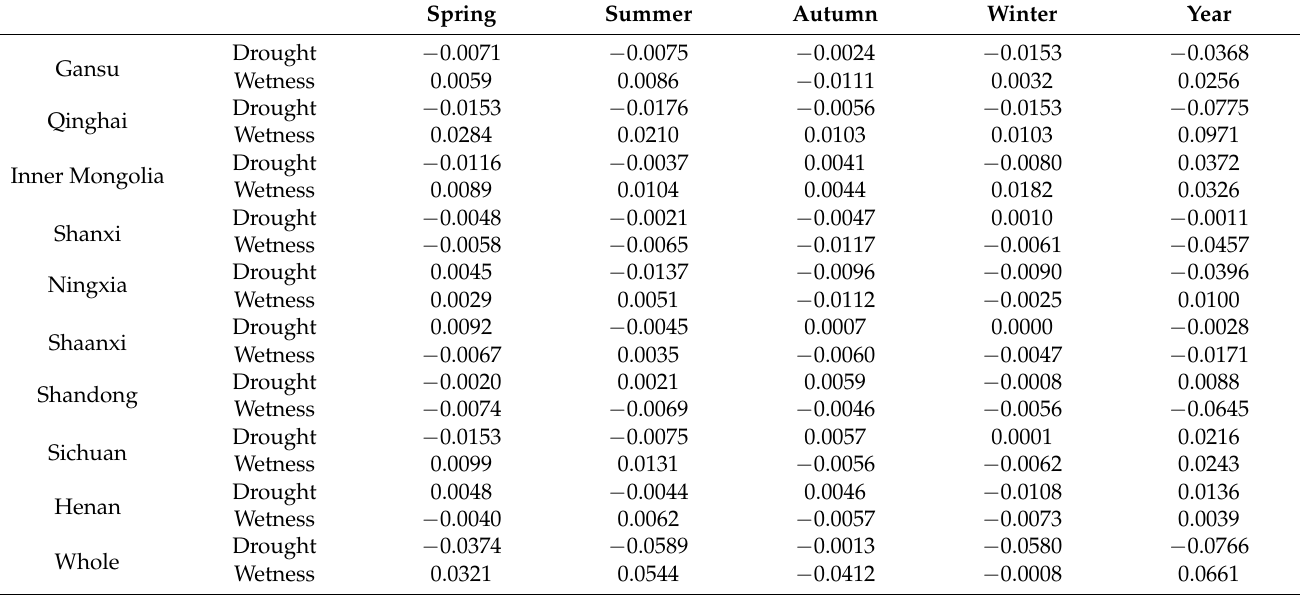
Table 2. Trends of drought and wet events in the nine provinces of the Yellow River basin from